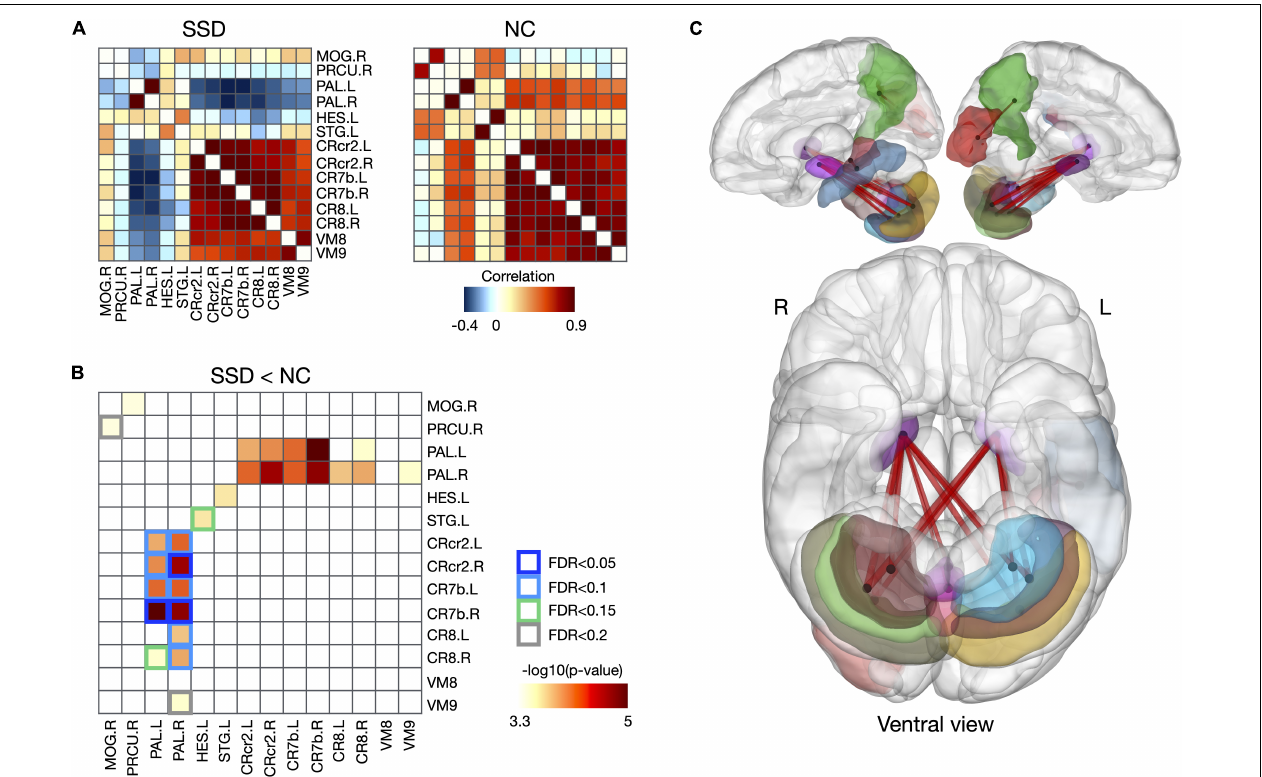
FIGURE 3 | Disrupted structural covariance connectivity in patients with SSD. (A) Group-averaging structural covariance connectivity for SSD and NC group. (B) Reduced structural covariances and relating regions in patients with SSD, and (C) their 3D rendering. SSD, somatic symptom disorder; NC, normal control; MOG, middle occipital gyrus; PRCU, precuneus; PAL, pallidum; HES, Heschl’s gyrus; STG, superior temporal gyrus; CRcr2, cerebellar crus 2; CR7b, cerebellar lobe 7b; CR8, cerebellar lobe 8; VM8, vermis 8; VM 9, vermis 9; L, left; R,